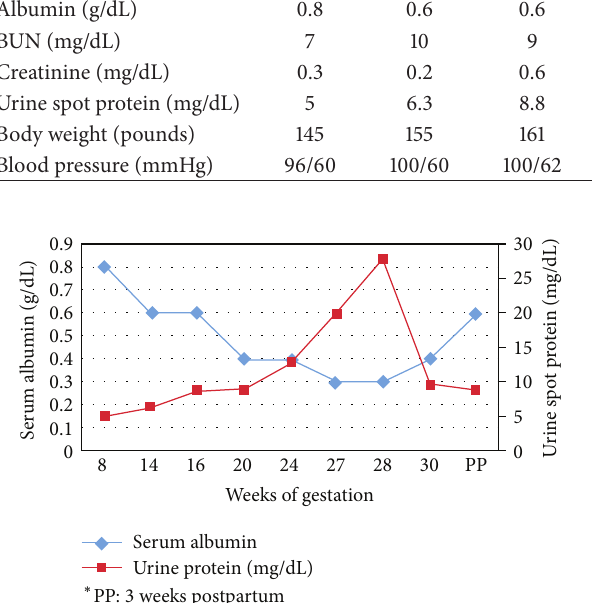
Figure 1: Graph of serum albumin and protein versus gestational week of pregnancy.